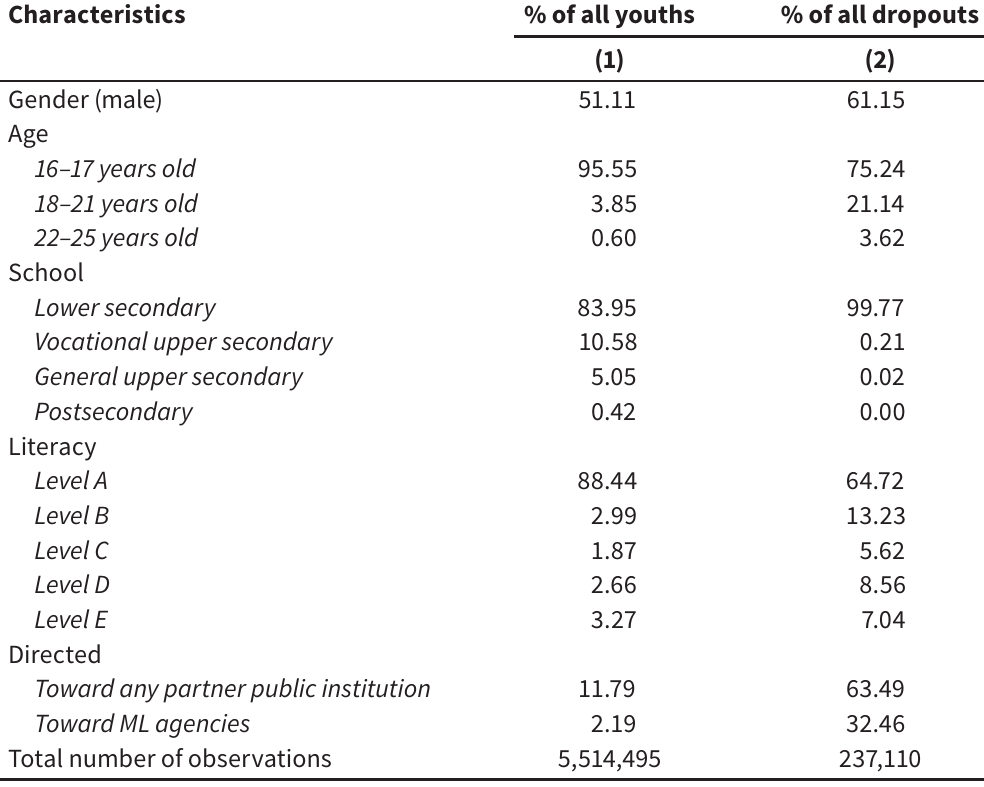
Table 1 Descriptive statistics of all youths and dropouts during army days Characteristics % of all